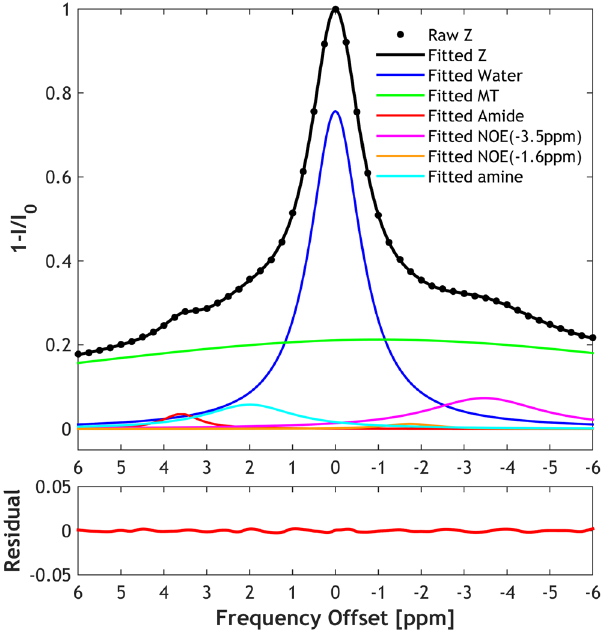
Figure 5. Multi-pool Lorentzian fit of the global Z spectra from a rat brain to determine initial values for IDEAL fitting, including saturation transfer effects from − 3.5, − 1.6, 2, 3.5 ppm as well as direct saturation and MT